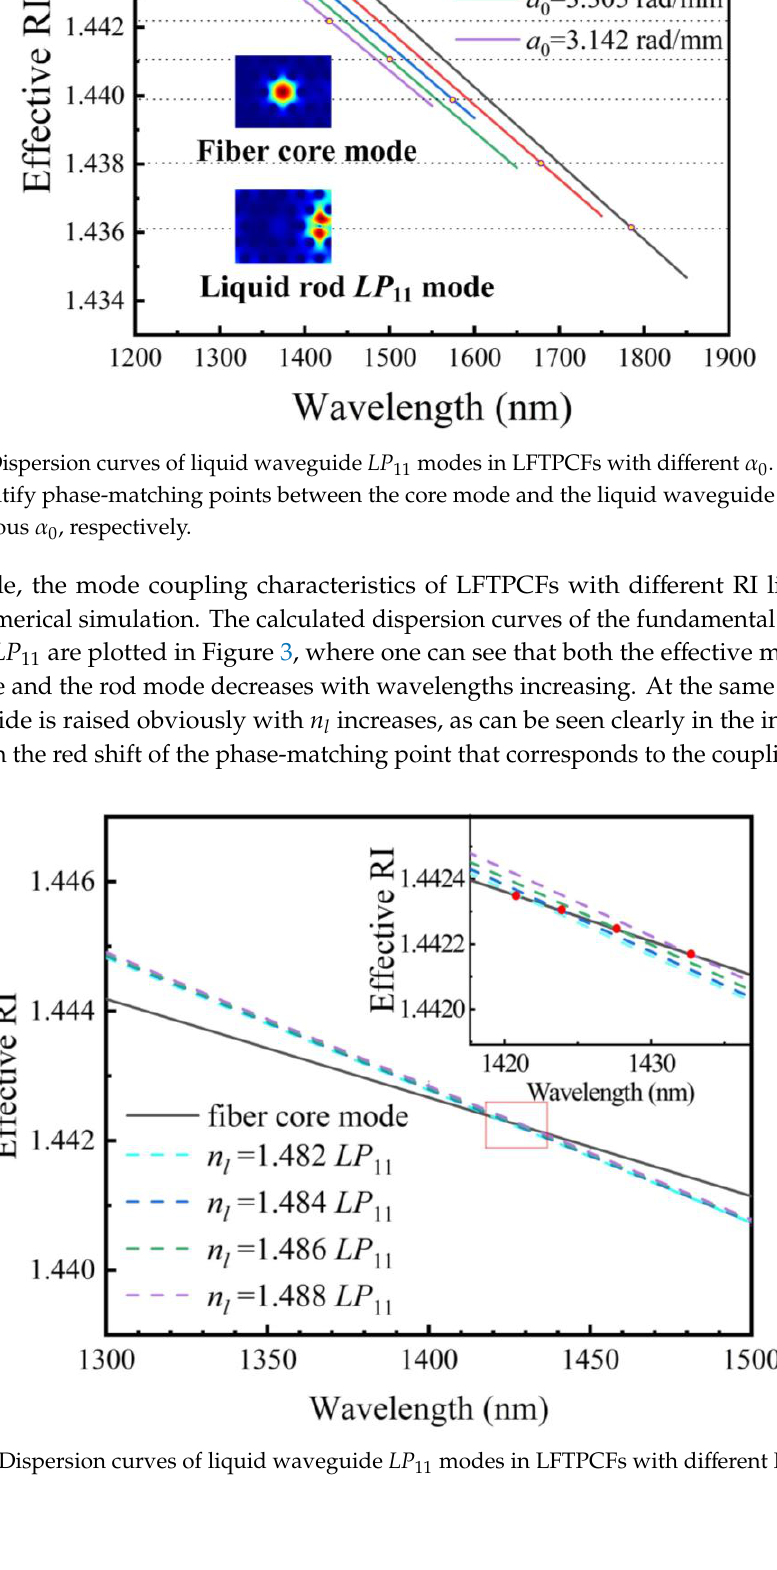
Figure 3. Dispersion curves of liquid waveguide LP 11 modes in LFTPCFs with different RI liquids.